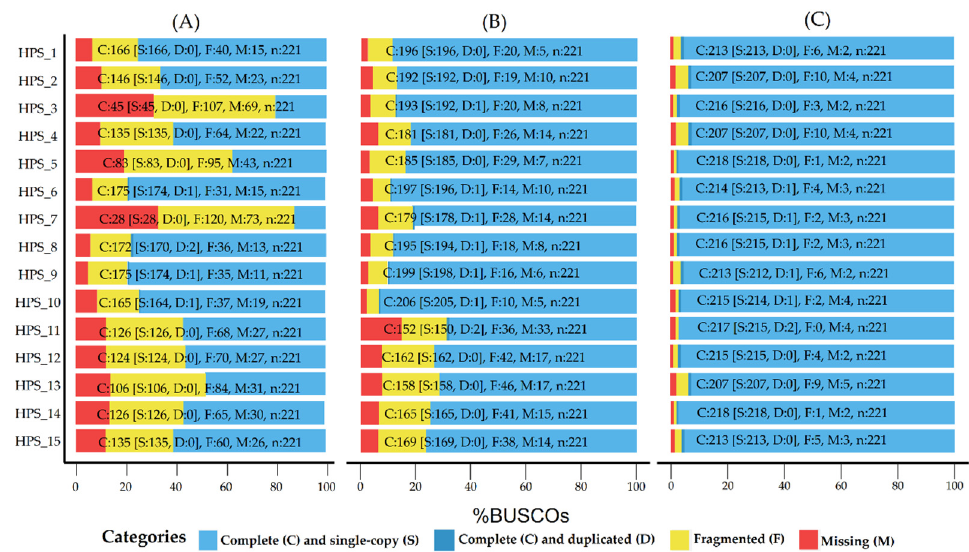
Figure 5. Evaluation of completeness of assembly results of 16 isolates. Assessments of the completeness of assembly genomes with datasets of the proteobacteria_odb9 lineage. Bar charts were produced with the BUSCO plotting tool to show proportions that were classified as complete (C, blue), complete single copy (S, light blue), complete duplicated